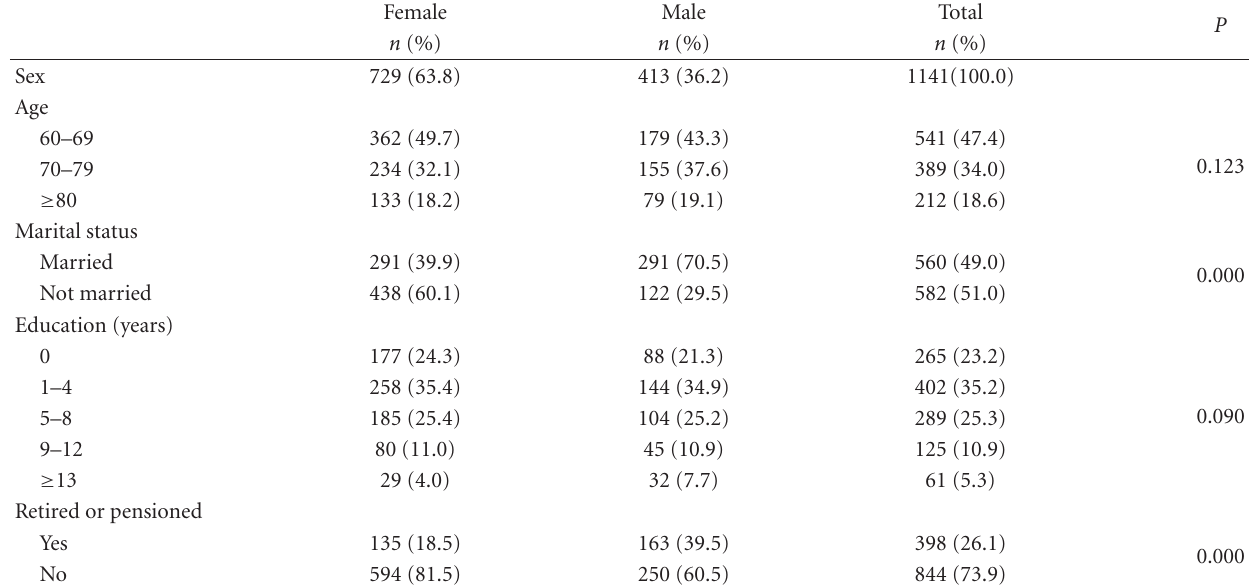
Table 1: Sociodemographic di ff erences in 1142 adults studied (413 men and 729 women) from Guadalajara, Jalisco, Mexico: marital status, education, and social benefit of retired or pensioned.